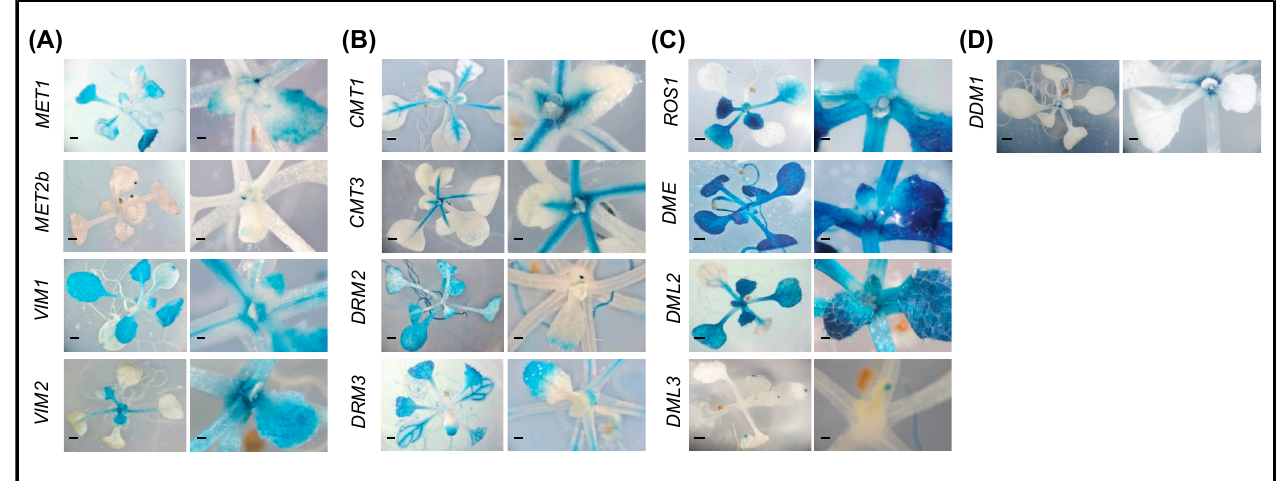
Figure 2. Promoter activity of DNA methylation and demethylation-related genes in two-week-old shoots. A–C: Histo- chemical localization of GUS activity directed by the promoters of the CG methylation-related genes MET1 , MET2b , VIM1 , and VIM2 ( A ), the non-CG and RdDM-related methyltransferases CMT1 , CMT3 , DRM2 , and DRM3 ( B ), the demethylases ROS1 , DME , DML2 , and DML3 ( C ), and DDM1 ( D ). Scale bar = 5 mm.